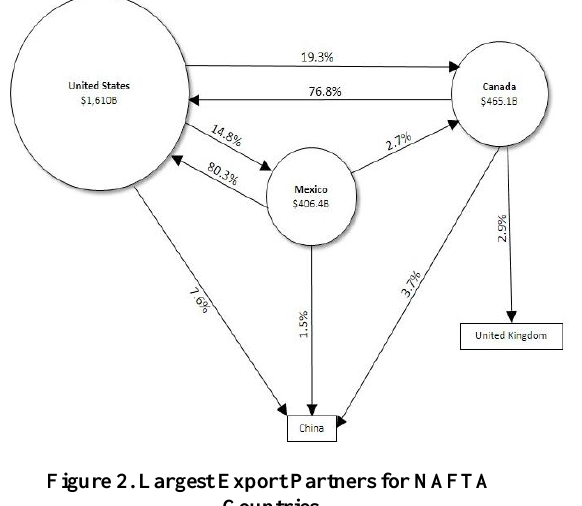
Figure 2. Largest Export Partners for NAFTA Countries